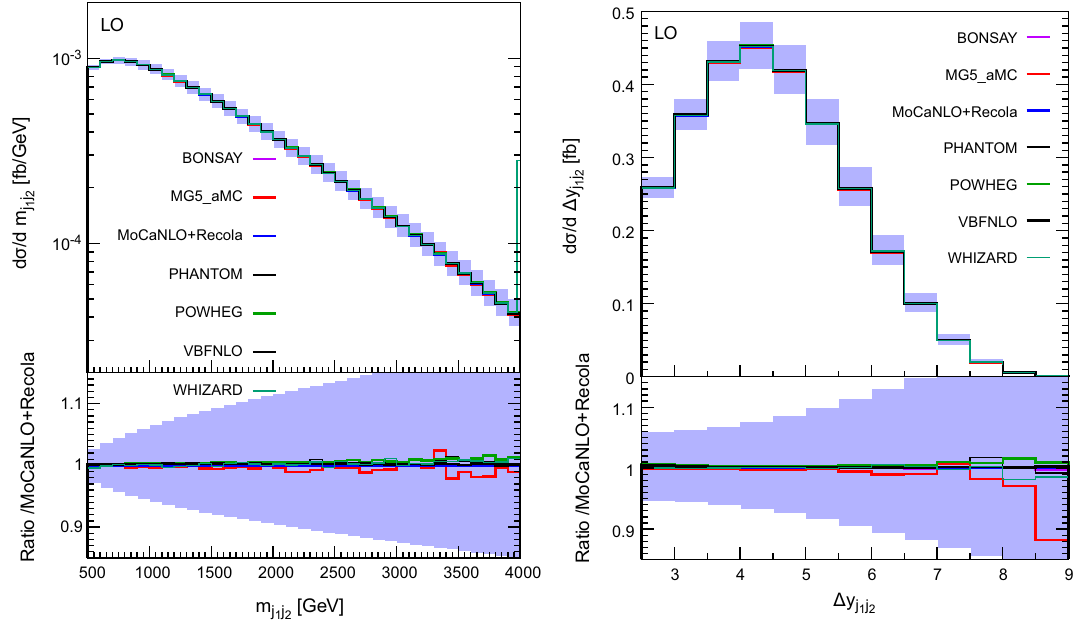
MoCaNLO + Recola which is one of the programs that provide the full prediction. The band corresponds to a seven-point variation of the renormalisation and factorisation scales. The predictions are obtained in the fiducial region described in Sect.